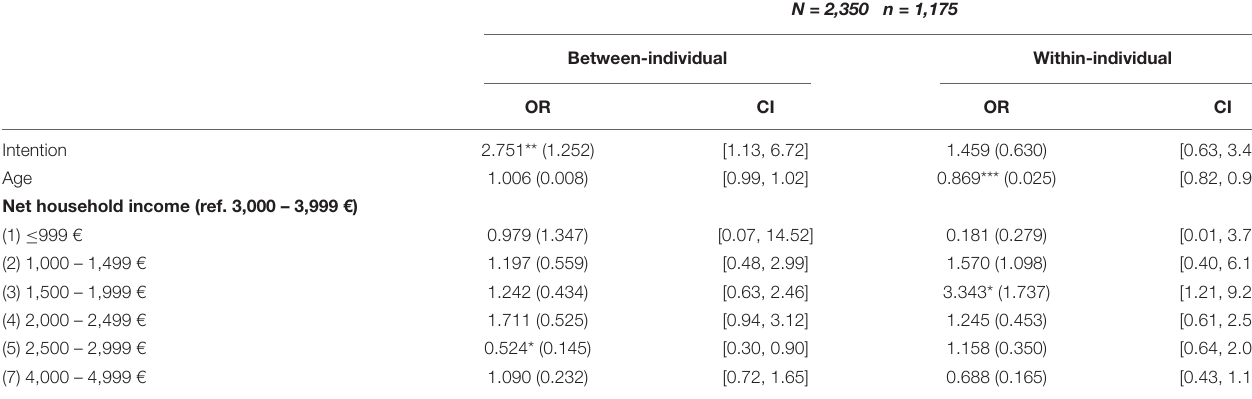
Between-individual